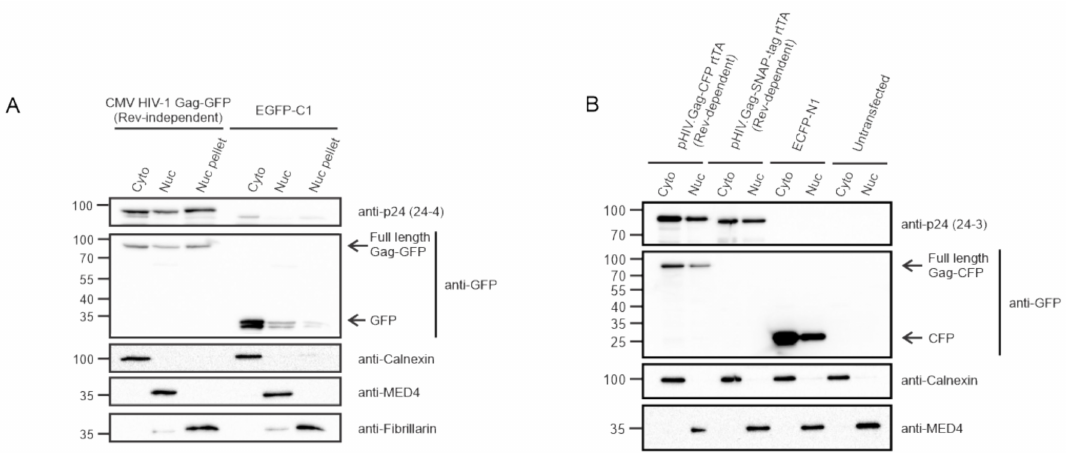
Figure 2. Presence of HIV-1 Gag in cytoplasmic and nuclear subcellular fractions. ( A ) Hela cells transfected with CMV HIV-1 Gag-GFP and EGFP-C1 plasmids were fractionated into cytoplasmic (Cyto), nucleoplasm (Nuc), and nuclear pellet (Nuc pellet) and analyzed by immunoblot using anti-p24 and anti-GFP antibodies. EGFP-C1 serves as negative control. Fraction purity was assessed using Calnexin (cytoplasm), MED4 (nucleoplasm), and fibrillarin (nucleolar, nuclear pellet). ( B ) Immunoblot of HeLa rtTA cell cytoplasmic and nuclear fractions following transfection with either pHIV.Gag-CFP rtTA, pHIV.Gag-SNAP-tag rtTA, or ECFP-N1 compared to untransfected cells. Fractions were